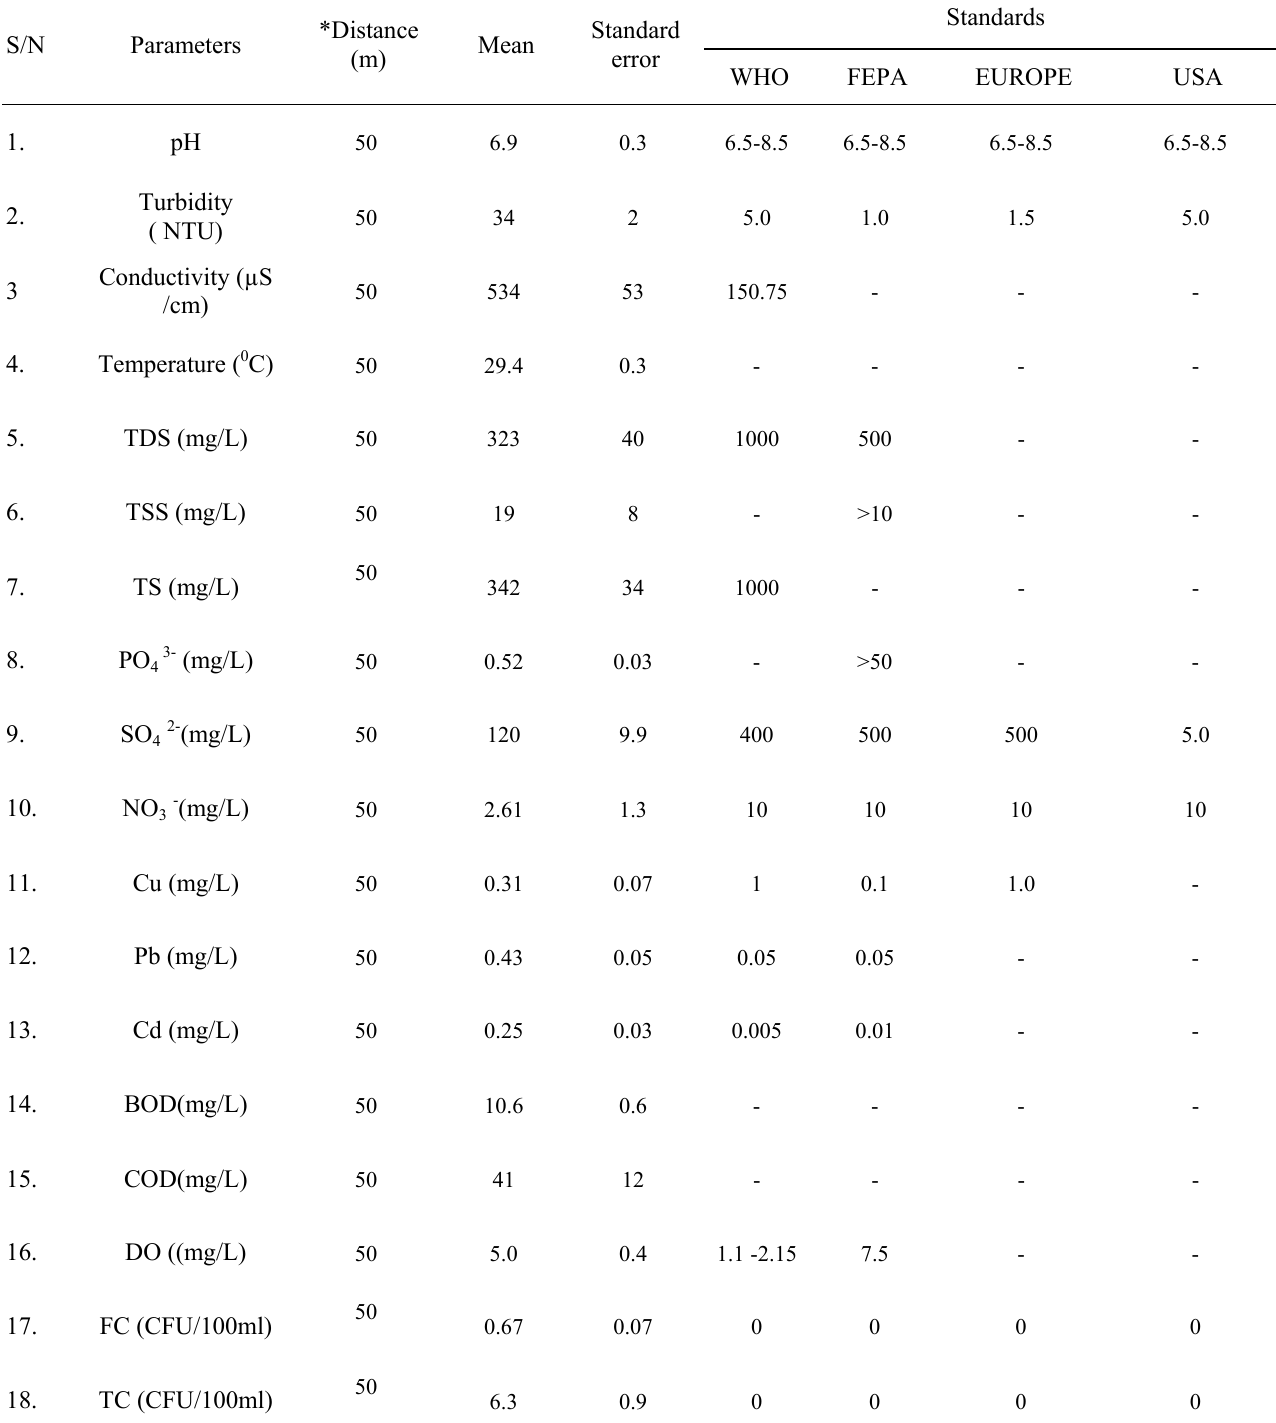
Table 6 : Mean values for the water quality parameters of wells located close to waste dumpsite in the wet season